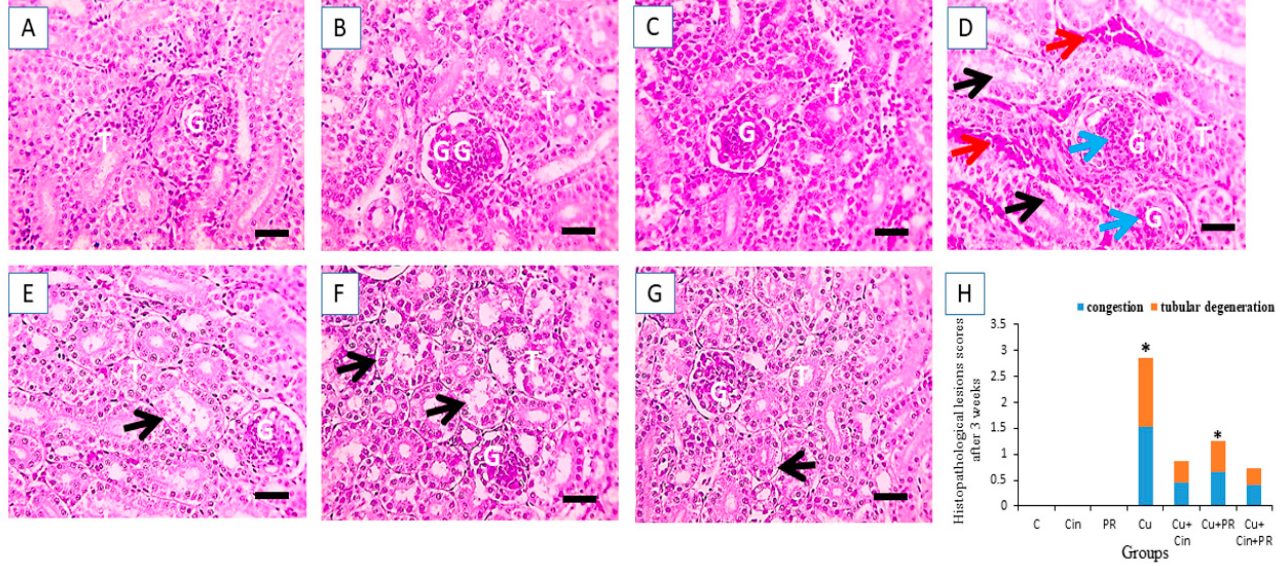
Figure 5. Light photomicrographs of chicken kidney sections (stained with H&E, X 400) after 3 weeks of the experiment. ( A – C ) Control group ( C ), cinnamon group (Cin), and probiotic group (PR): showing normal glomeruli (G) and tubules (T). ( D ) Copper group (Cu): revealed degenerated glomeruli (blue arrows) and tubules (black arrows) and congested intertubular capillaries (red arrows). ( E ) Cu + Cin group: showing mildly vacuolated tubular epithelium (black arrows) in few tubules. ( F ) Cu + PR group: showing mildly vacuolated tubular epithelium (black arrows) in few tubules. ( G ) Cu + Cin + PR group: very mildly vacuolated tubular epithelium (black arrows). ( H ) Semiquantitative scoring of renal tubular degeneration and congestion. * Significance compared to control ( p < 0.05). Scale bar = 50 µm.